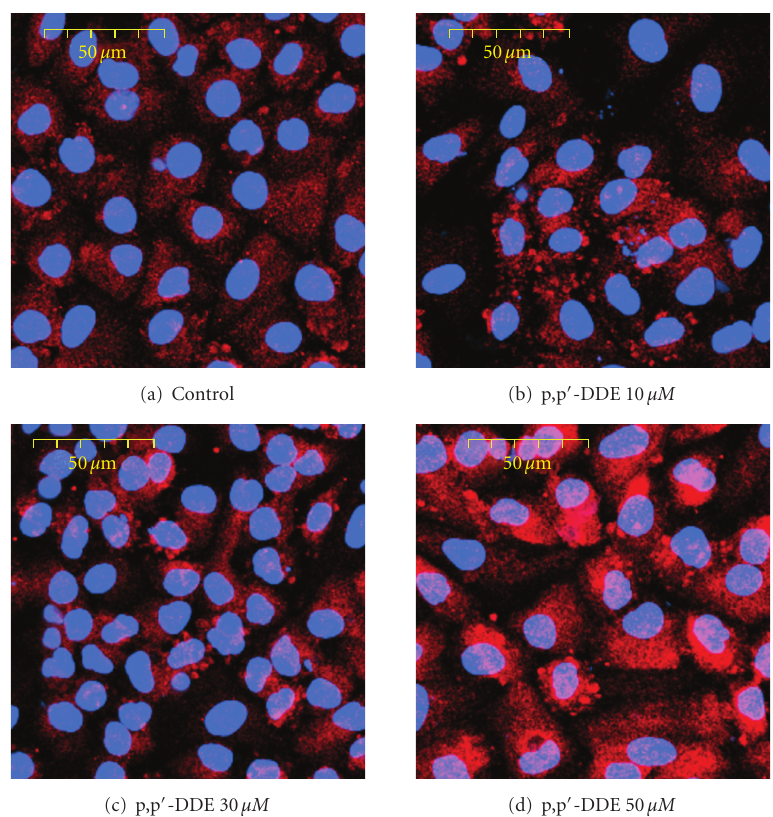
Figure 6: E ff ect of p,p (cid:2) -DDE on NF- κ B activation in rat Sertoli cells by laser scanning confocal microscope (40 × ). Representative images for NF- κ B activation in control (a), 10 μ M (b), 30 μ M (c), and 50 μ M (d) p,p (cid:2) -DDE-treated groups. There was a dose-dependent increase in nuclear translocation of NF- κ B in Sertoli cells. In 50 μ M p,p (cid:2) -DDE-treated group , the nuclear translocation was more